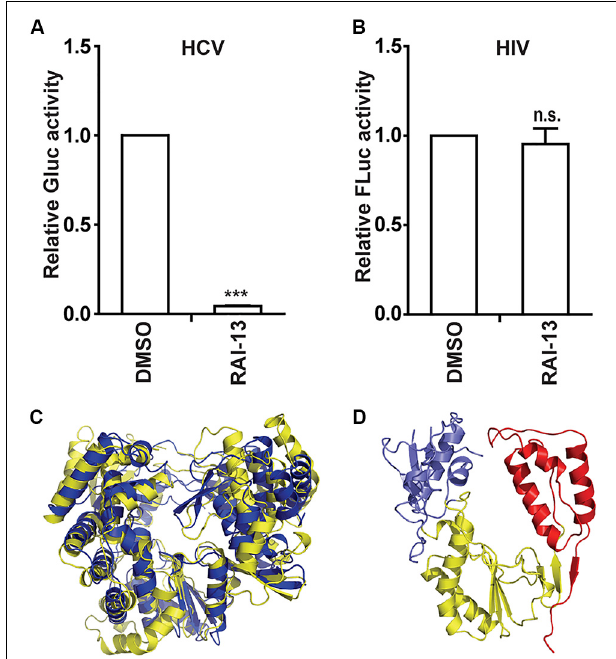
FIGURE 9 | The inhibitory effects of RAI-13 on HCV and HIV-1. (A) Jc1-Gluc HCVcc was used to infect Huh7.5.1 cells, which were treated with 1 um RAI-13. Levels of HCV infection were measured by detecting the Gluc activity in cell culture supernatants at 48 hpi. (B) VSVG/HIV-Fluc was used to infect HEK293T cells in the presence of 2 µ M RAI-13 for 48 h, and then cells were harvested and lysed. Infection of HIV-1 was measured by detecting Fluc activity in the cell lysates. (C) Superimposition of the RdRp structures of DENV (yellow) and HCV (blue). (D) The polymerase structure of HIV-1 RT-P66 (PDB ID 1HMV). The fingers, palm, and thumb domains were shown in blue, yellow, and red respectively. Data are representative of at least three independent experiments, and values are expressed as means ± SD. Data are normalized to the control group, with the control value arbitrarily set to 1. * P < 0.05; ** P < 0.01; *** P < 0.001; and n.s., not